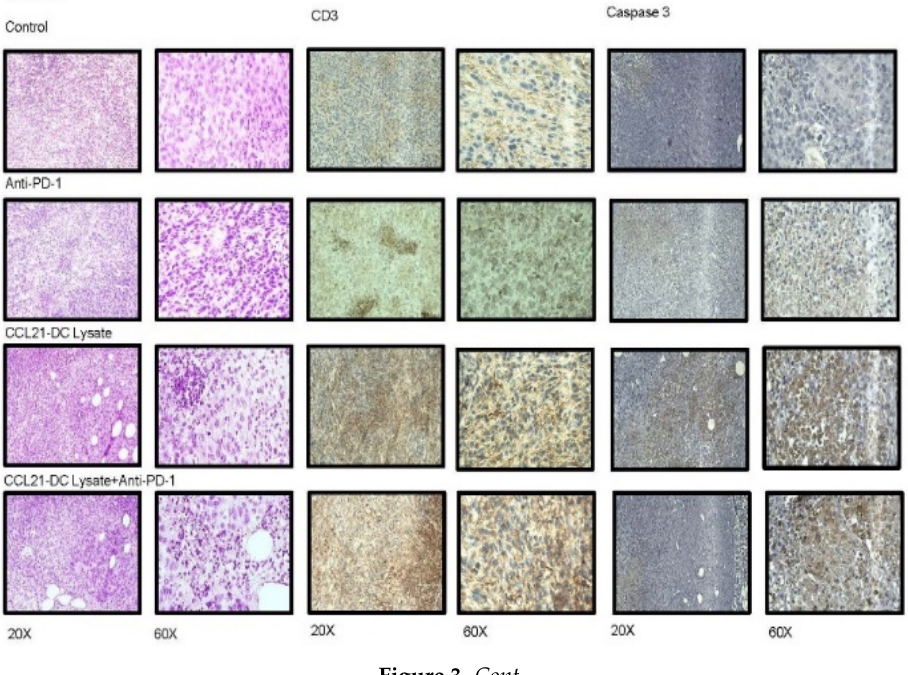
Figure 2. Tumor-infiltrating T cells (TILs) were incubated with K-RasG12Dp53null tumor cells at ratio of 5:1 overnight followed by addition of almar blue for 4 h. TILs from mice treated with combined therapy were most effective at lysing K-RasG12Dp53null tumor cells; ** p < 0.01 in comparison to diluent control, * p < 0.05 compared to monotherapy. Results are representative of an independent experiment ( A ). The experiment was repeated twice ( n = 4 mice/group). Flow cytometric analyses of single-cell suspensions of the tumor microenvironment (TME) following therapy showed enhancement of CD8 T cells expressing granzyme B ( p < 0.05) compared to monotherapy. Results are representative of an independent experiment. The experiment was repeated twice ( n = 4 mice/group) ( B